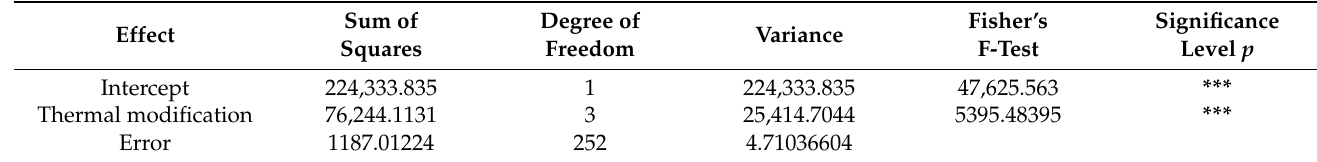
Table 6. Statistical evaluation of the factors affecting the change in the ∆ E